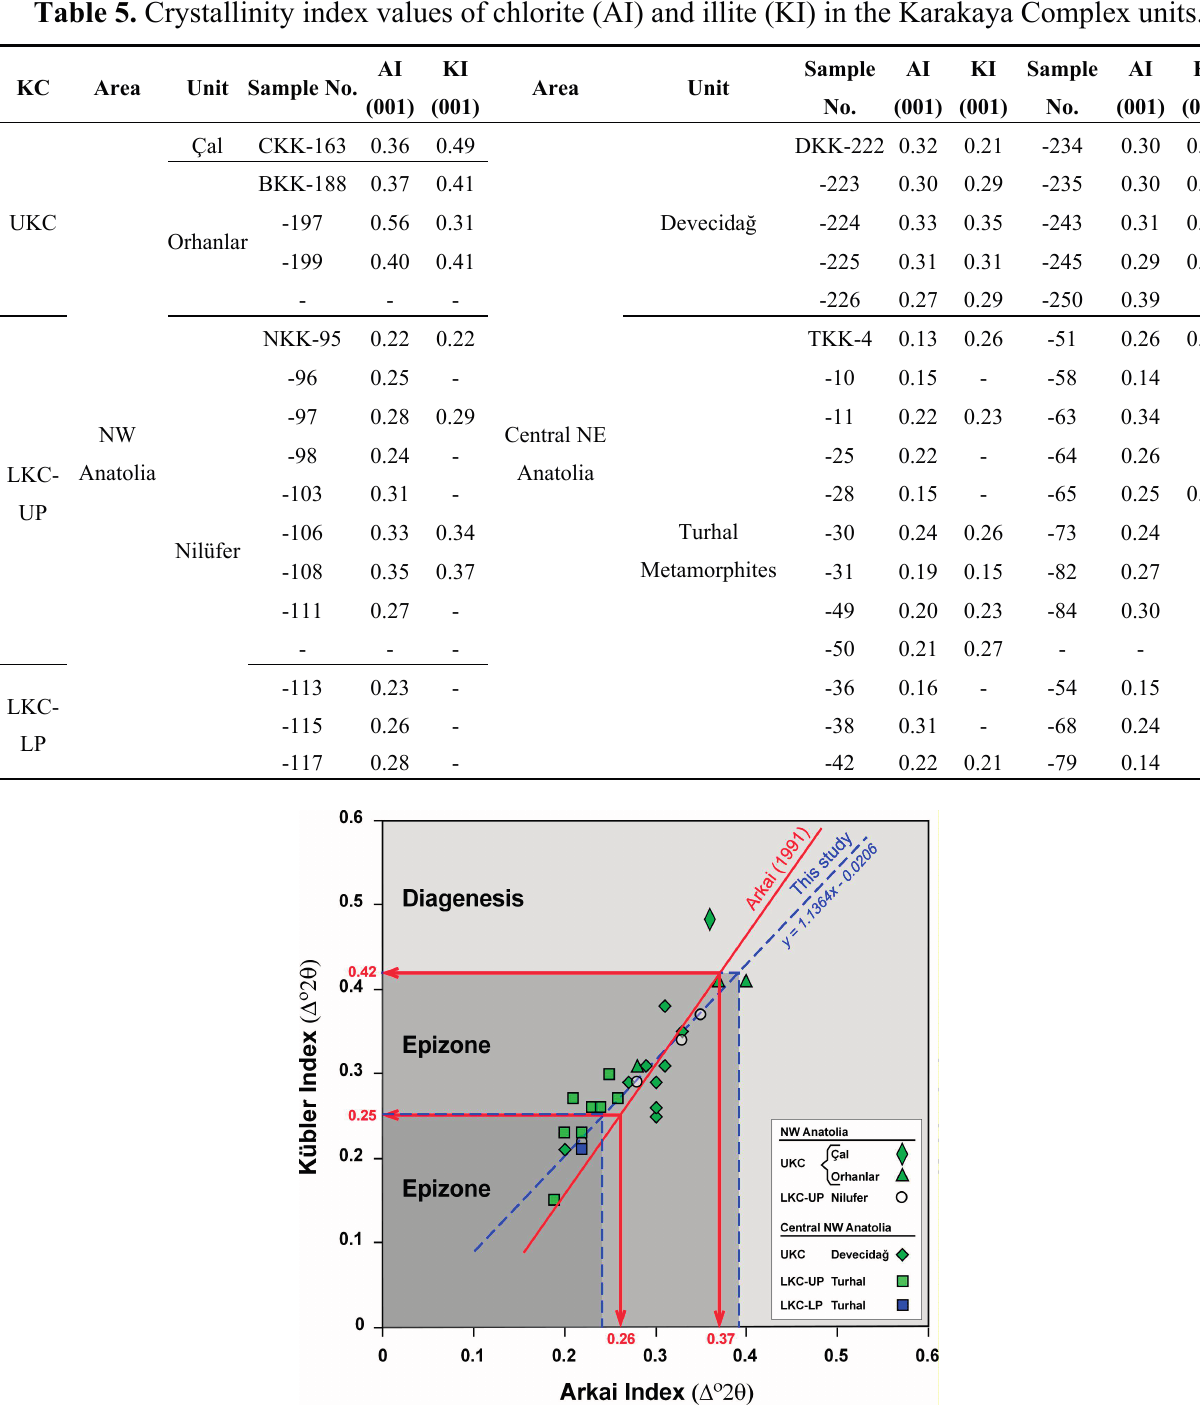
Figure 10. Relationships between Kübler Index ( Δ °2 θ )-Arkai Index ( Δ °2 θ ) in the Karakaya Complex units (red line and values: Arkai